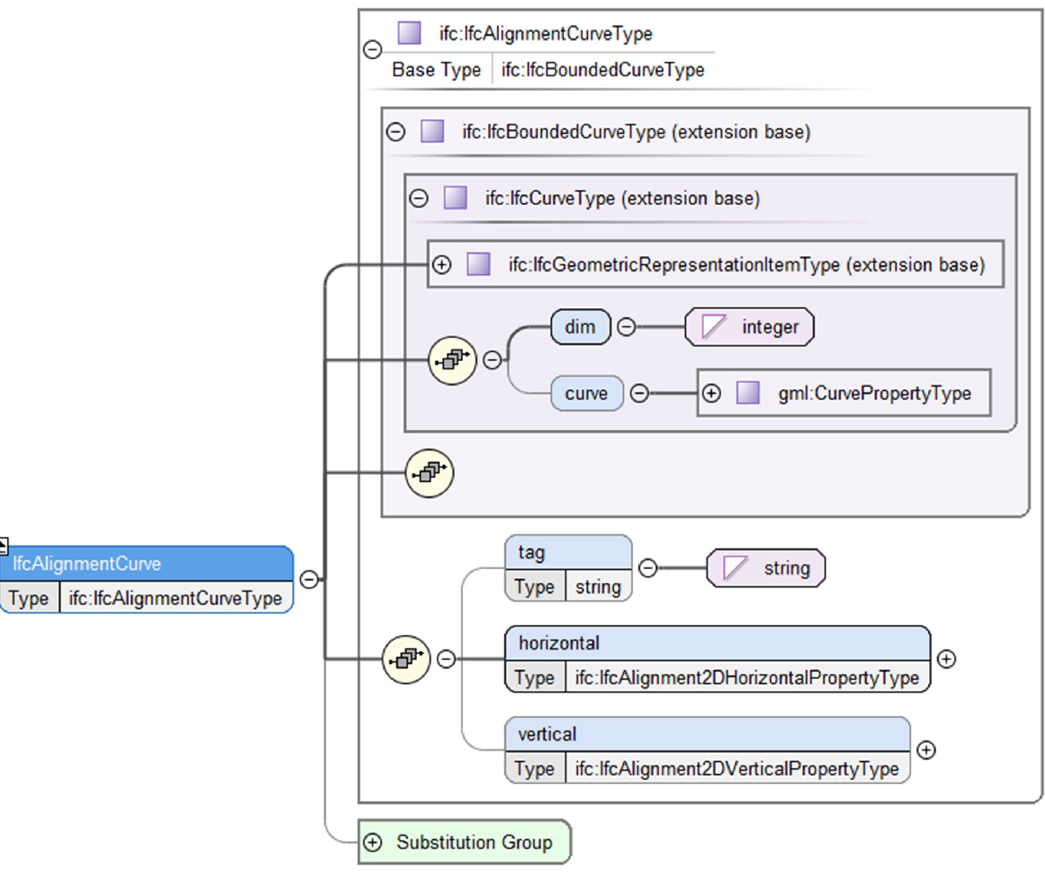
Figure 18. Extract from the IfcGeometricConstraintResource GML schema, illustrated in Oxygen XML Editor [57].